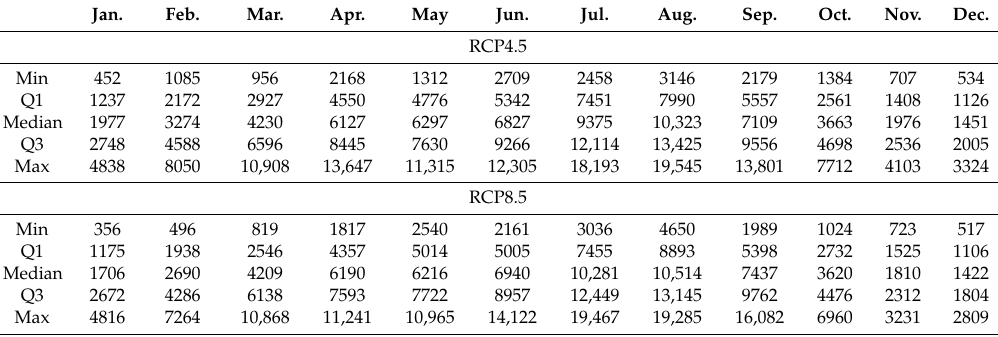
Table 2. Statistic of projected monthly flow simulation using the XAJ model (unit: m 3 /s). Jan. Feb. Mar. Apr. May Jun. Jul. Aug. Sep.